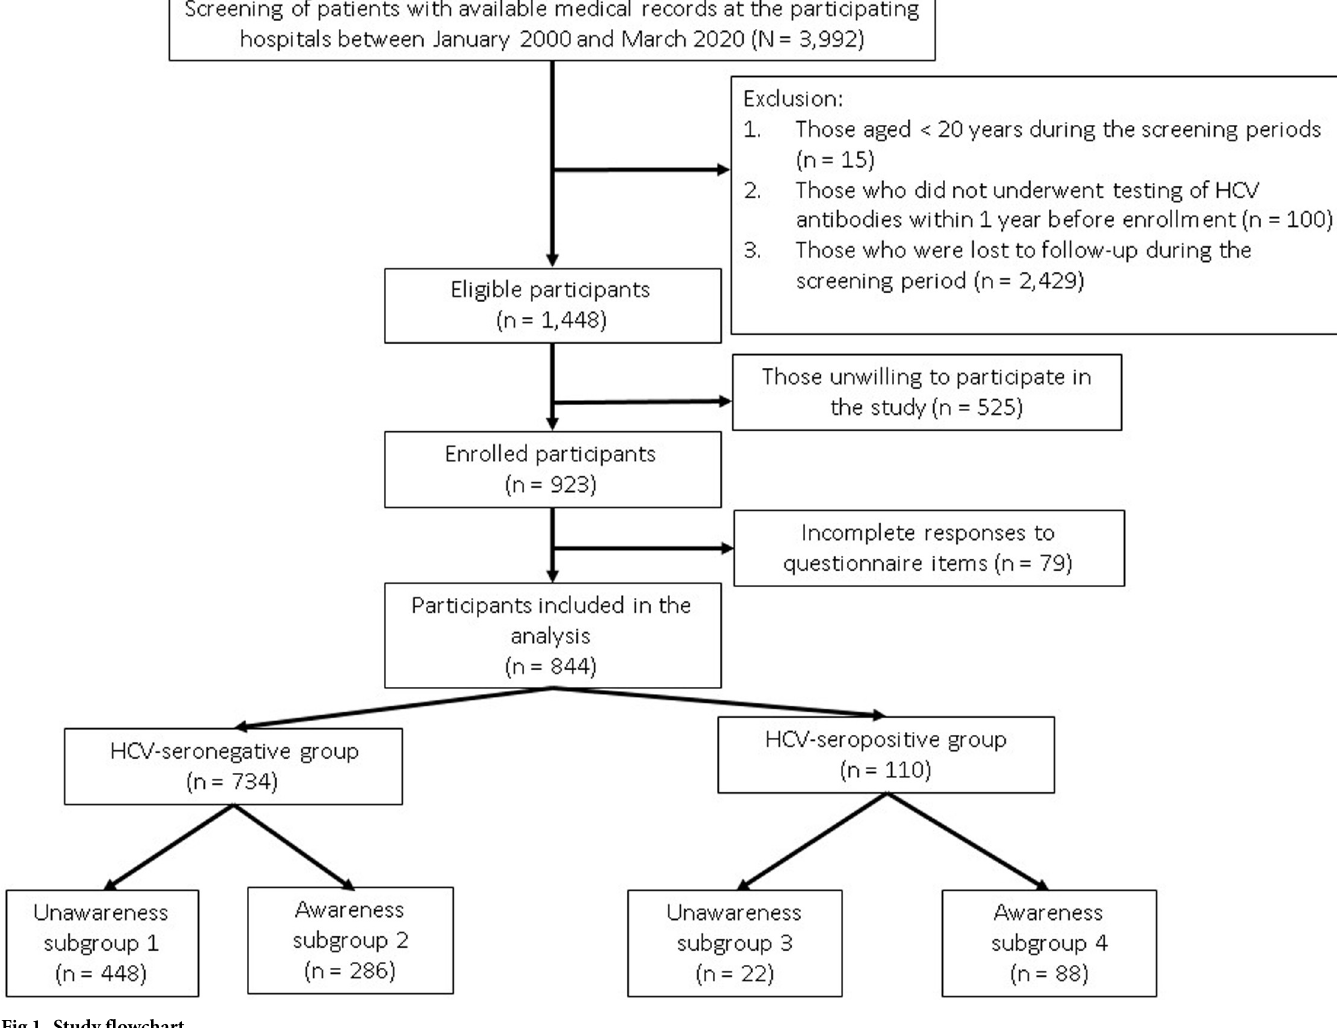
(8.3%), and drug injection (5.2%). Approximately 21.0%, 30.2%, and 48.8% of the participants were diagnosed as having HIV in periods 1, 2, and 3, respectively. Trend analysis of the prevalence of UoHCV across the three periods stratified by participants’ HCV serostatus The prevalence rate of UoHCV was 46.9% in period 1, 54.5% in period 2, and 60.2% in period 3 (p for trend = 0.003; Fig 2). The overall prevalence of UoHCV was 58.7%–62.6% in the HCV-seronegative group (p for trend = 0.497) and 15.1%–31.3% in the HCV-seroposi- tive group (p for trend = 0.086). Participants with a history of treatment for HCV were excluded from the HCV-seropositive group because all of these patients were aware of their HCV infection status and were thus not part of the target population; this exclusion increased the prevalence of UoHCV to 33.8% (ranging from 30.8% in period 1 to 37.0% in period 3, p for trend = 0.632).